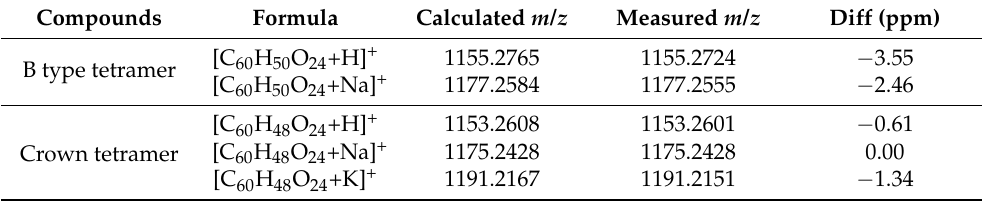
Table 1. Positive ions of B type procyanidins’ tetramer and crown procyanidins’ tetramer. Compounds Formula Calculated m/z Measured